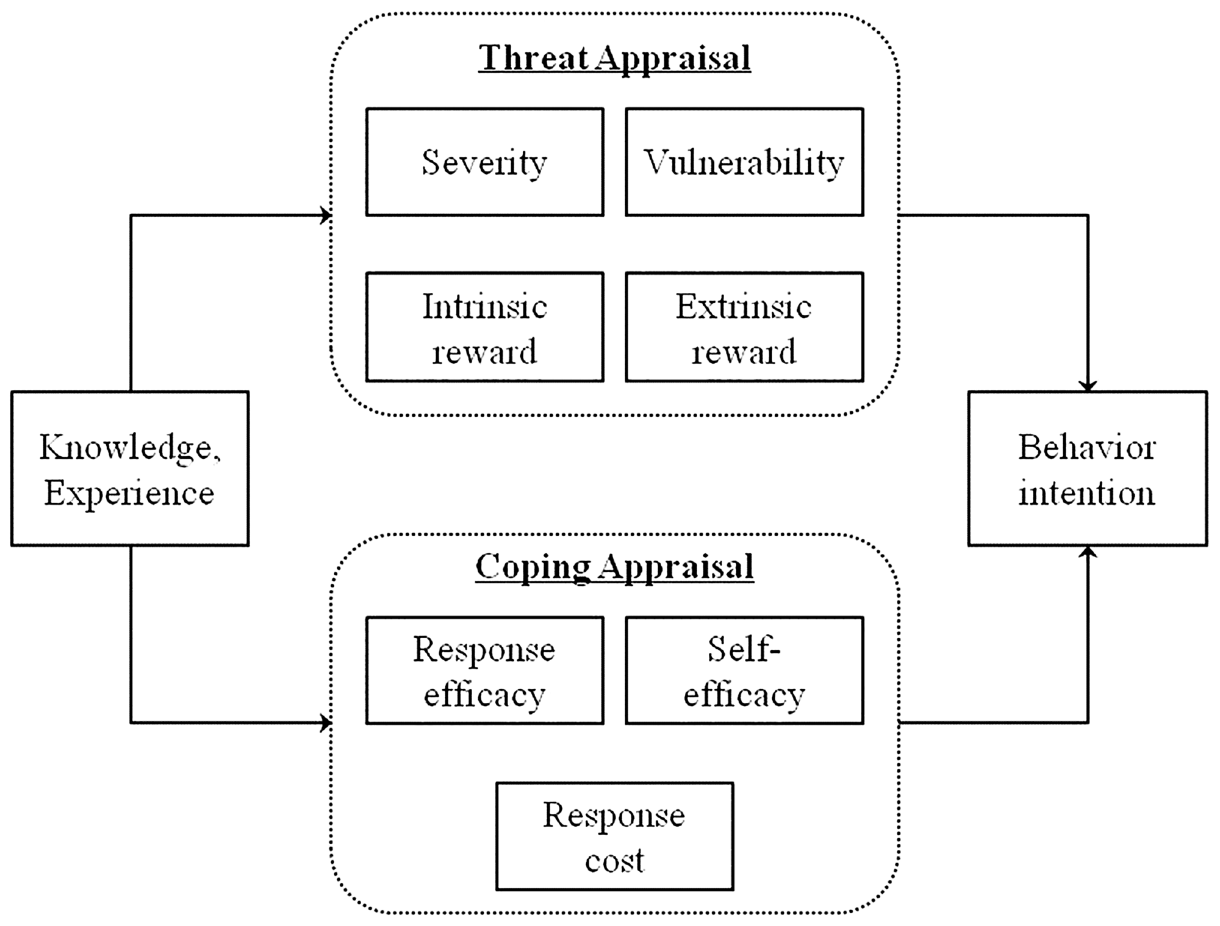
Figure 1. Schematic presentation of the Protection Motivation Theory (PMT) and its seven subconstructs. PMT consists of seven constructs organized as two pathways (i.e. the threat appraisal pathway and the coping appraisal pathway) linking perceptions to behavior. The threat appraisal pathway consists of four constructs in two groups (severity and vulnerability, intrinsic rewards and extrinsic rewards). Coping appraisal pathway consists of three subconstructs in two groups (response efficacy and self-efficacy, response